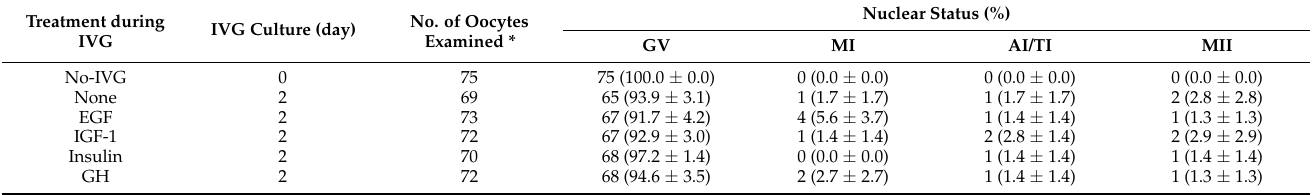
Table 4. Nuclear stage of small antral follicle derived pig oocytes after in vitro growth (IVG) culture in a medium supplemented with various growth factors and hormones.